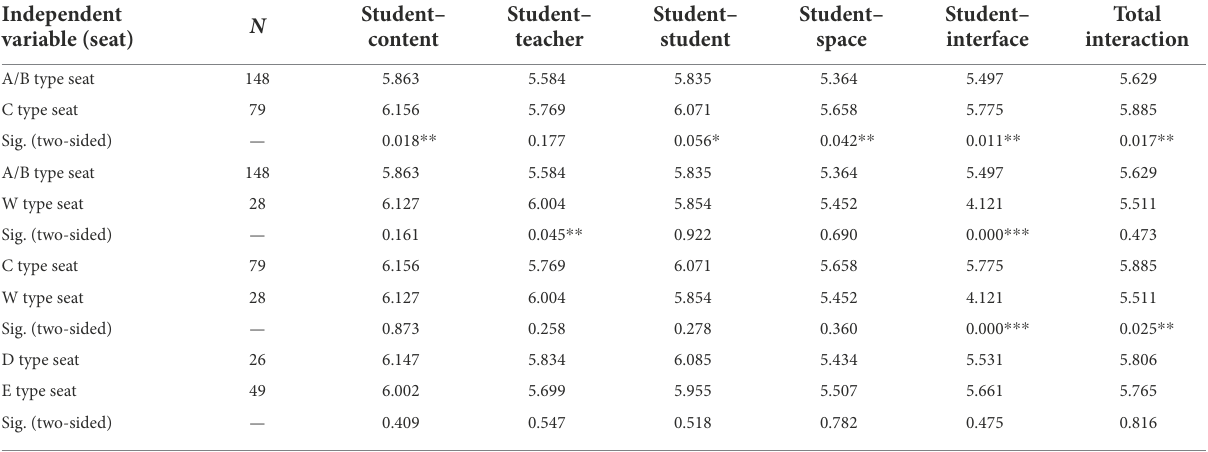
TABLE 3 Relationship between seat type and interaction